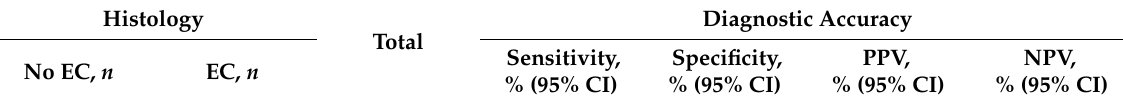
Table 5. Diagnostic accuracy of serum CA125 and HE4 for the detection of endometrial